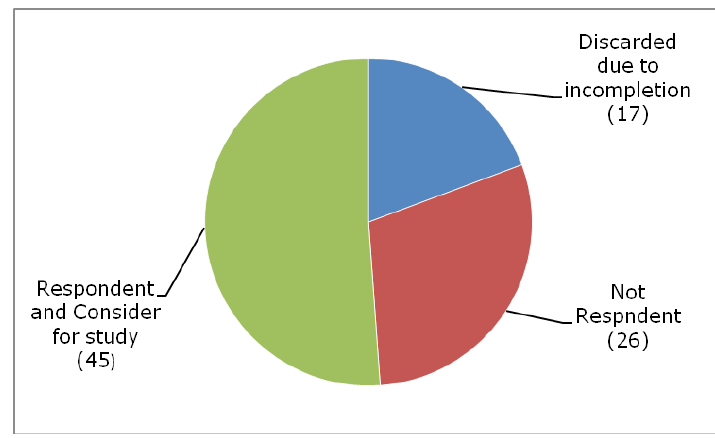
Figure 1. Responses of Questionaire Based Survey Carried Out